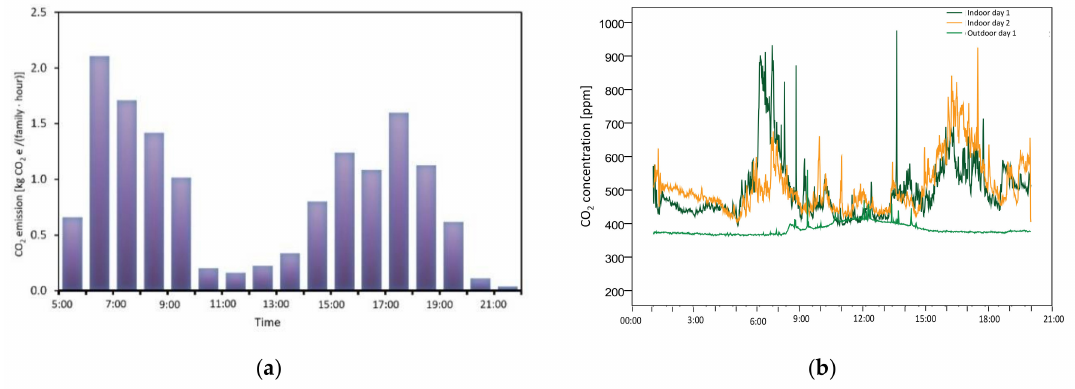
Figure 9. Diurnal variation of CO 2 : ( a ) CO 2 emissions and ( b ) CO 2